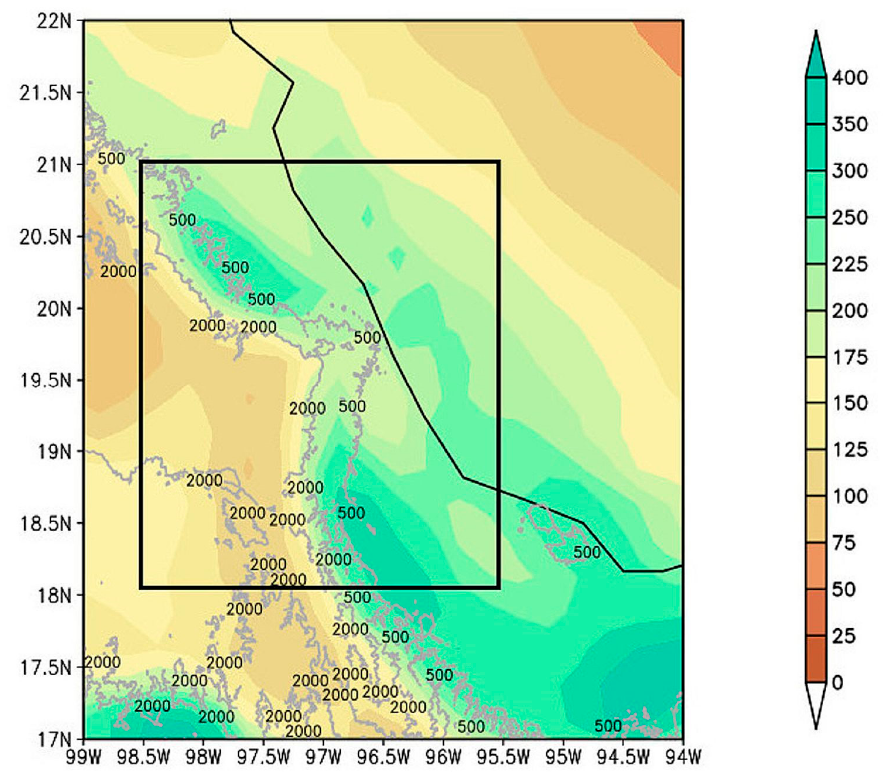
Figure 5. Monthly mean rainfall (mm mo -1 ) for summer (May to October) from CMORPH data 2015 using a spatial resolution of 2.5° x 2.5° and considering the period 1998-2015. The contours of 500 and 2000 m.a.s.l. are shown. The square shows the VCZ. Near the top of the slope the rainfall values diminish, since in summer the Mexican Altiplano (high plateau) is above the trade inversion. Mosiño and García [28] found that the trade wind inflow